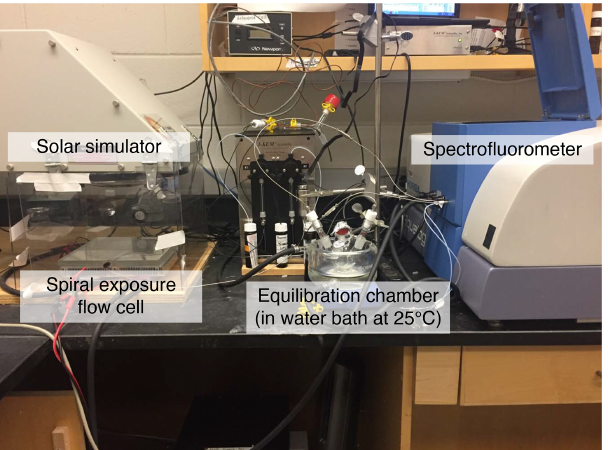
Figure A1. Photograph of the photoirradiation system, with key components labeled. A micro-gear pump circulates the sample between the equilibration chamber, a flow cell cuvette inside the spectrofluorometer, and the spiral exposure flow cell underneath the solar simulator lamp. A water bath set to 25 ◦ C (outside picture) circulates the water through the larger black tubing to the glass jacket surrounding the pictured water bath in which the equilibration chamber sits.